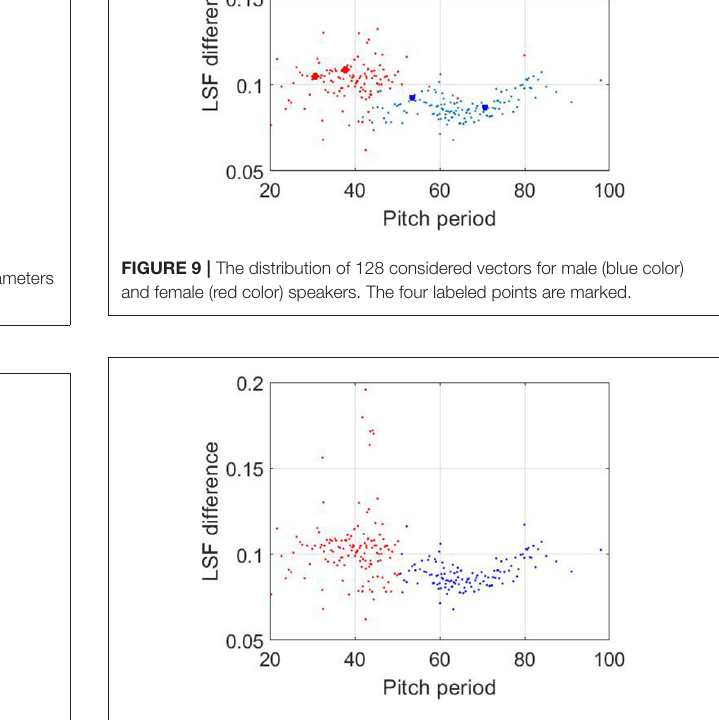
FIGURE 10 | The results of the vectors’ classification. Blue and red colors correspond to male and female speakers, respectively. The values of